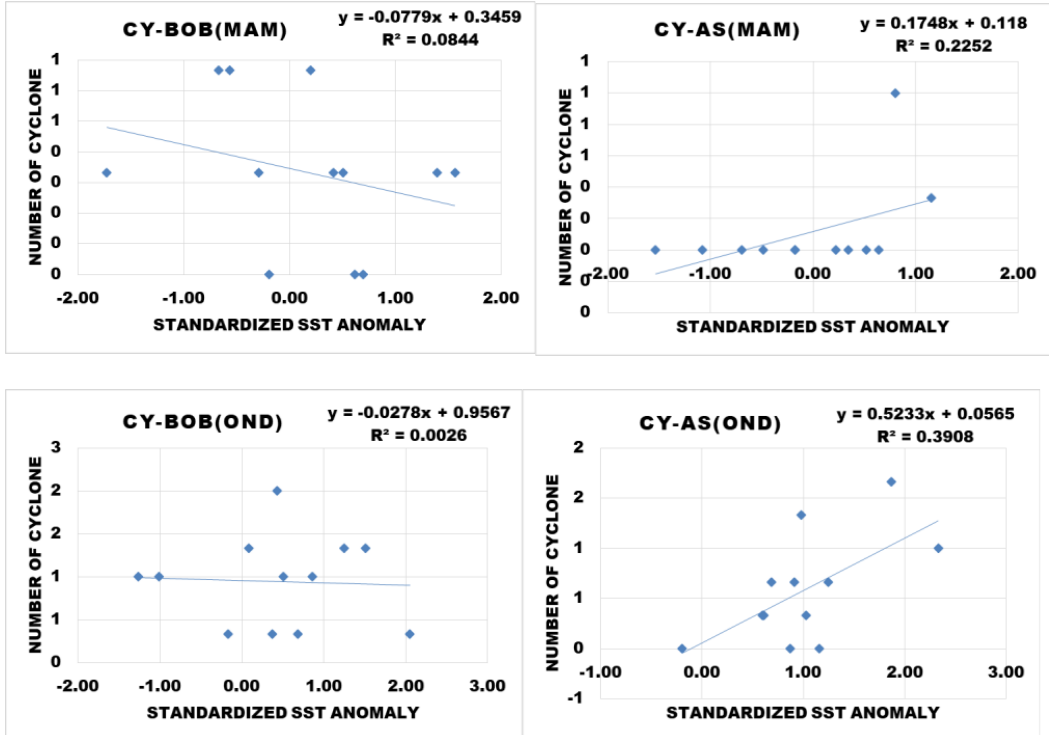
Figure 4. Scatter plots between standardized SST anomalies and number of cyclones (CY) for the positive IOD years for BOB − MAM, AS − MAM, BOB − OND and AS − OND.